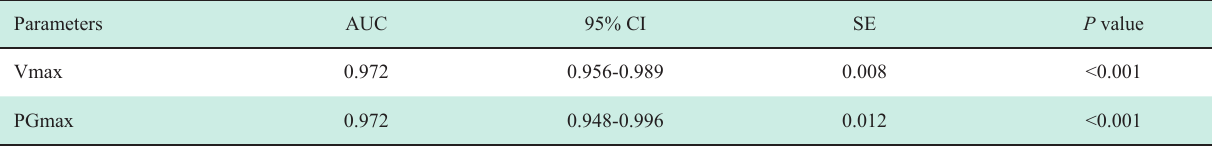
Table 4 The area under the ROC (AUC) of Vmax and PGmax at the stenosis site for determining IJV regional stenosis Parameters